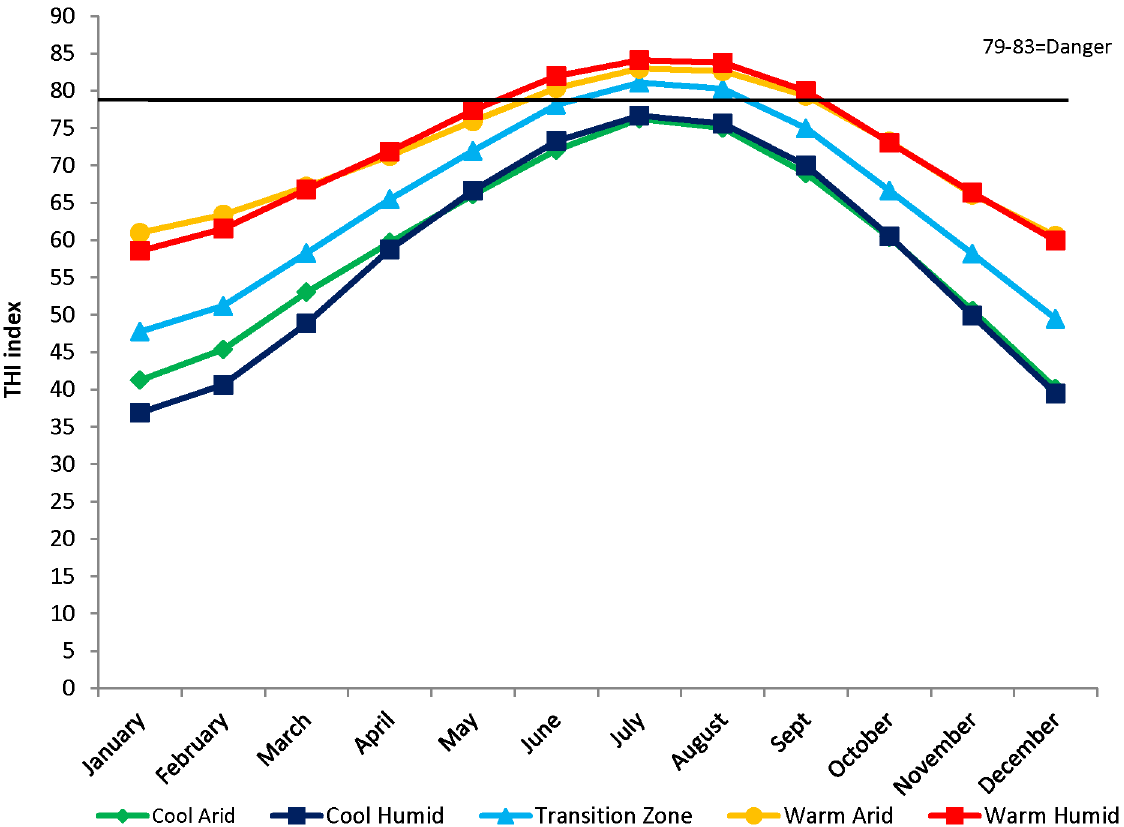
Fig 2. Averagemonthly thermal heat index by ecoregion, where the horizontal line denotes the threshold for the danger